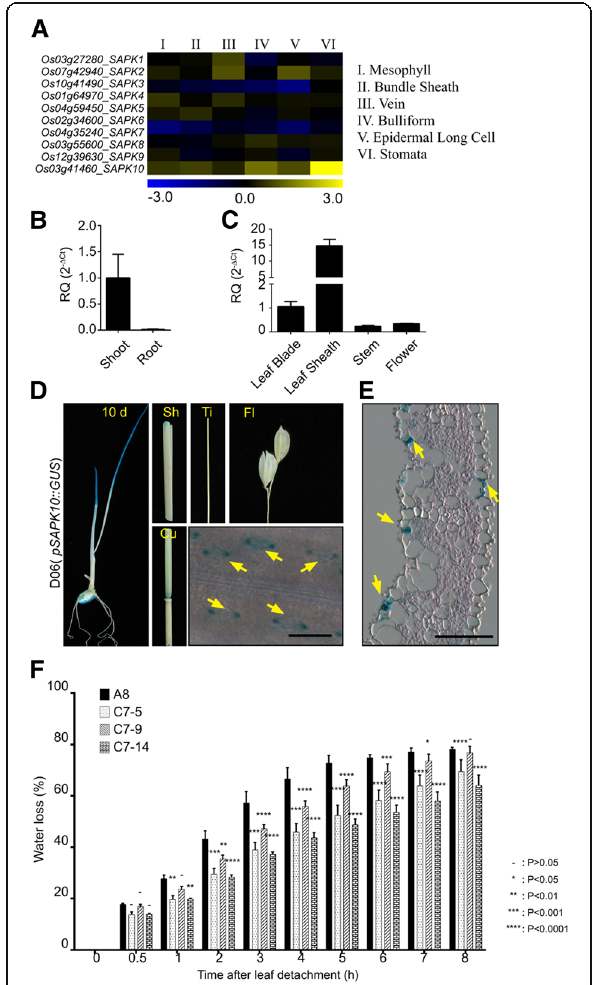
Fig. 2 SAPK10 is expressed dominantly in rice guard cells and OsSAPK10 -overexpressing transgenic rice presents less water loss. a Gene expression profiles of ten SAPKs in different rice cell types were presented as a heat map by using transcriptome analysis data from rice cells, black to yellow displayed increasing, black to blue displayed decreasing. b RT-qPCR analysis of OsSLAC1 gene expression in two-week-old seedlings. The generated RQ (relative quantity, 2 - Δ Ct ) was compared to the value of expression on shoot. OsUbiqutin5 was used as endogenous control. The values depict the average and ± SD with 3 replications. c RT-pPCR analysis of OsSLAC1 gene expression in different tissues of mature rice (80 days old). The values were compared to the expression level on leaf blade. d Histochemical β -glucuronidase analysis of SAPK10 promoter-GUS transgenic rice. Left image is a 10-day-old seedling. Sh (sheath), Ti (tiller), Fl (flower), Cu (culm) and leaf blade epidermis. Scale bars are 50 μ m. e A section of paraffin-embedded leaf blade stained with X-Gluc and eocin. Yellow arrows indicate guard cells. Scale bars are 50 μ m. f Water loss assays of SAPK10 -overexpressing transgenic lines (C7 – 5, 9 and 14) and control line (A8: empty vector transgenic rice). The picks depict the average and ± SD with 3 replications. ANOVA analysis was performed by comparing with water loss of A8 plant